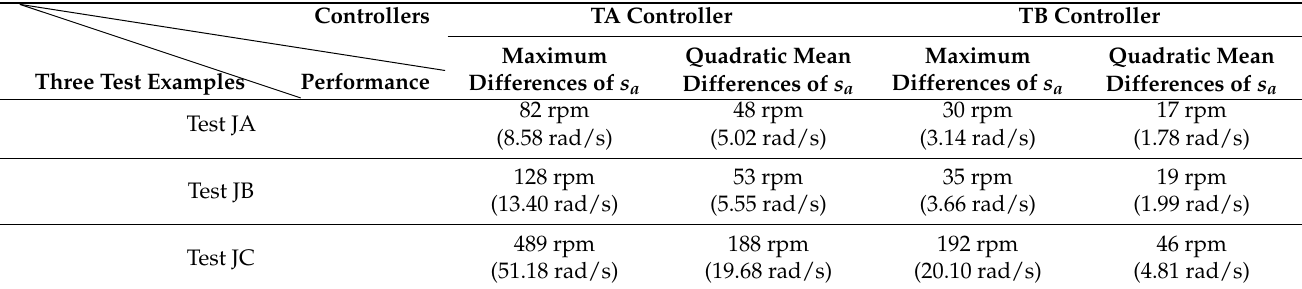
Table 1. Dynamic responses for the two